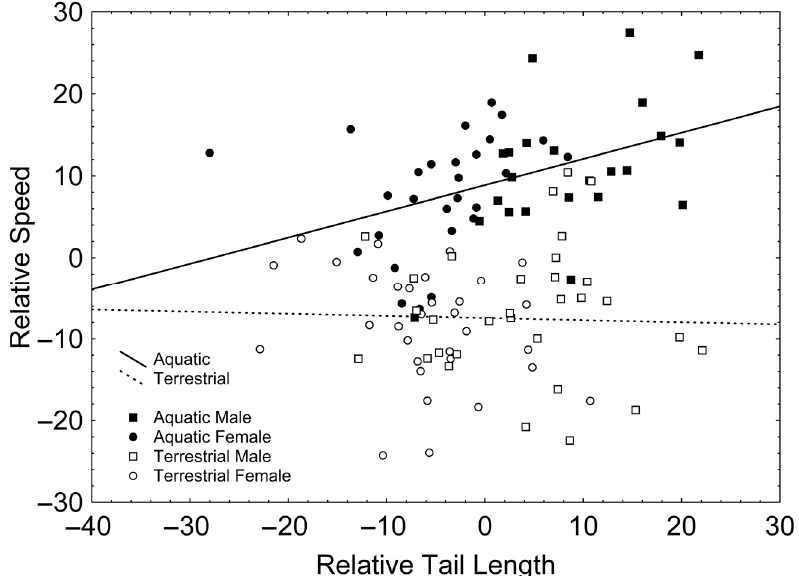
Figure 2. Correlations between relative tail length and relative speed in the aquatic (solid line) and the terrestrial phases (dashed line). Squares represent males whereas circles represent females. Solid symbols represent newts in the aquatic phase whereas empty symbols represent newts in the terrestrial phase.